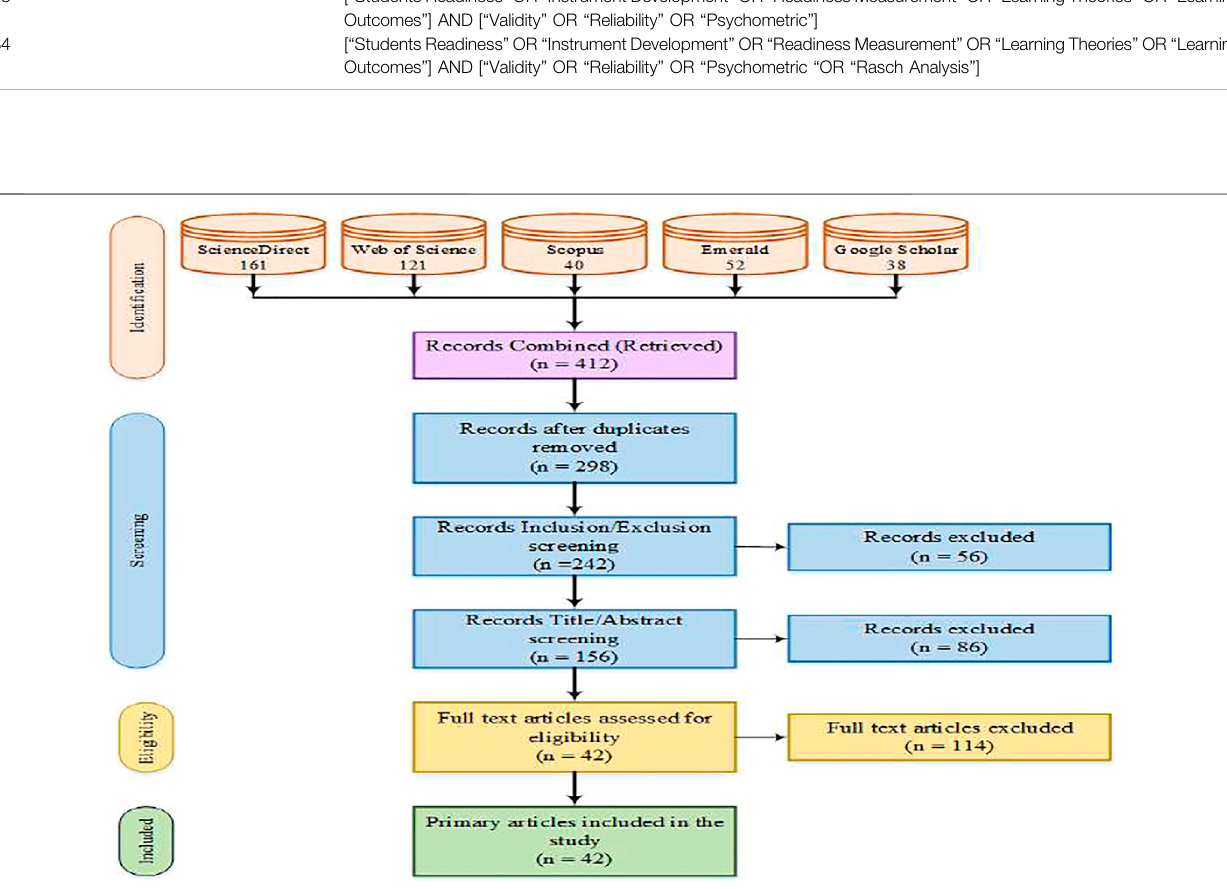
FIGURE 2 | Search